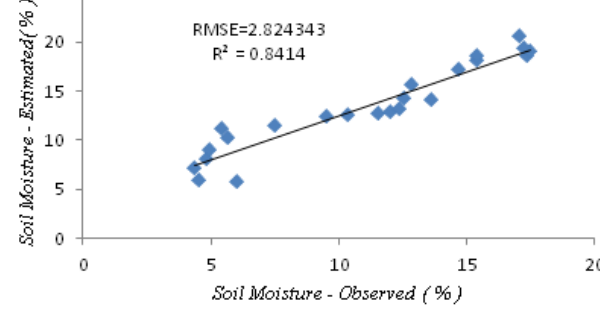
Fig. 14 Relationship between estimated soil moisture with MODIS Angle index (6,7) and observed soil